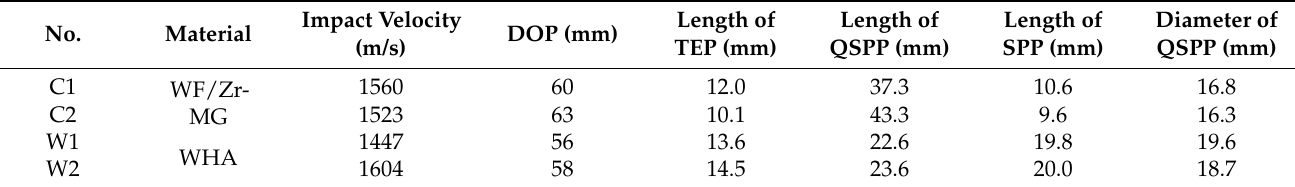
Table 2. Dimensions of the craters.